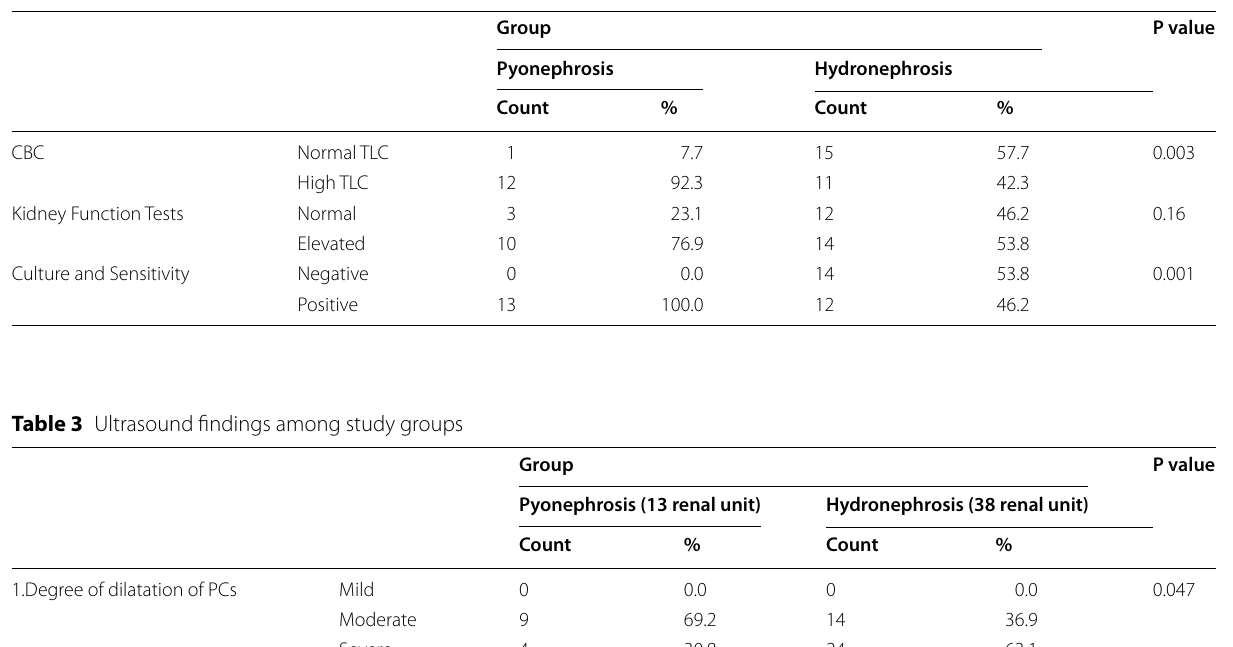
Table 2 Laboratory findings among the study groups